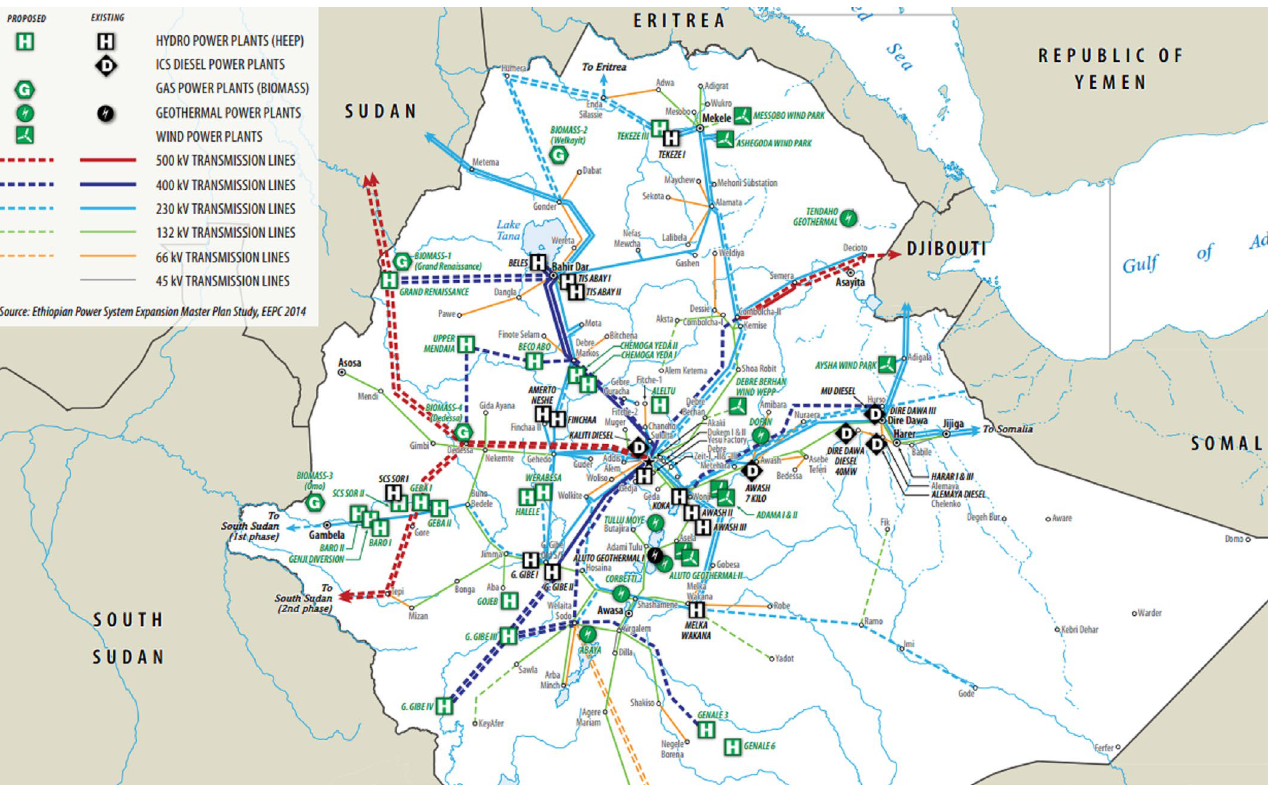
Figure 3. Location of existing and planned renewable generation stations